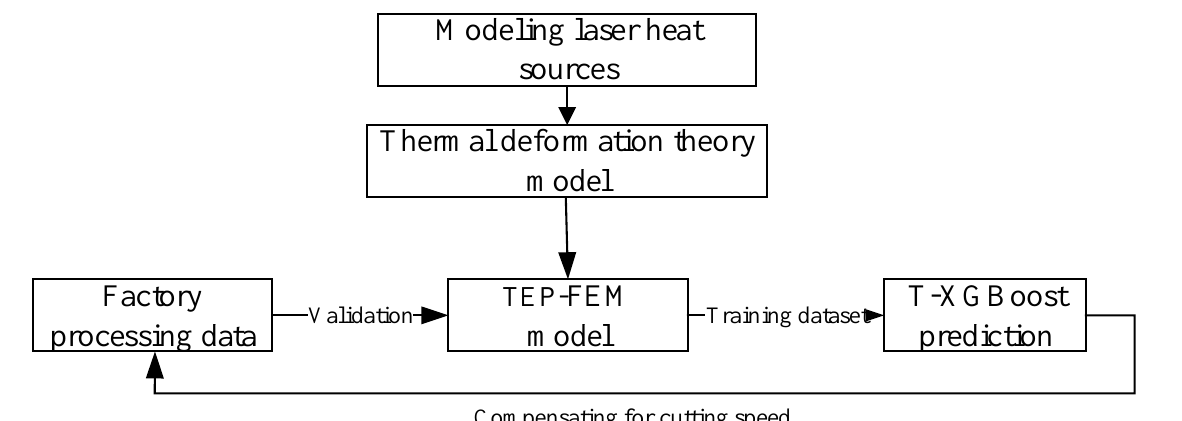
Figure 2. Hybrid model methods flow chart.